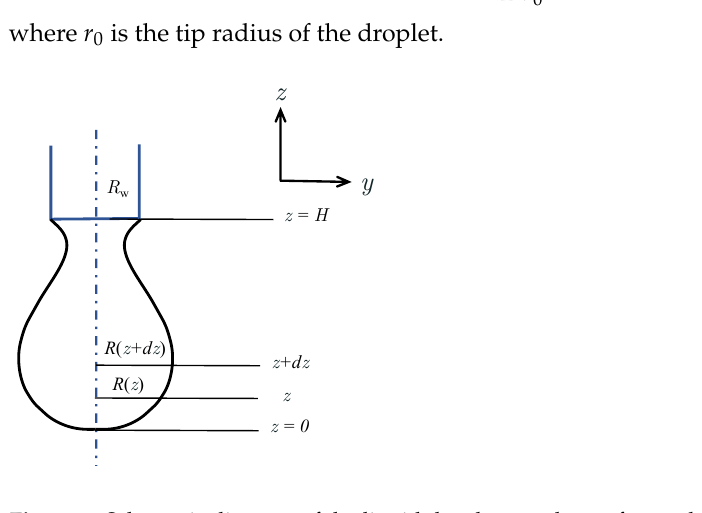
Figure 3. Schematic diagram of the liquid droplet metal transfer mode. The profile of the pendant droplet is obtained through a scheme similar to Algorithm